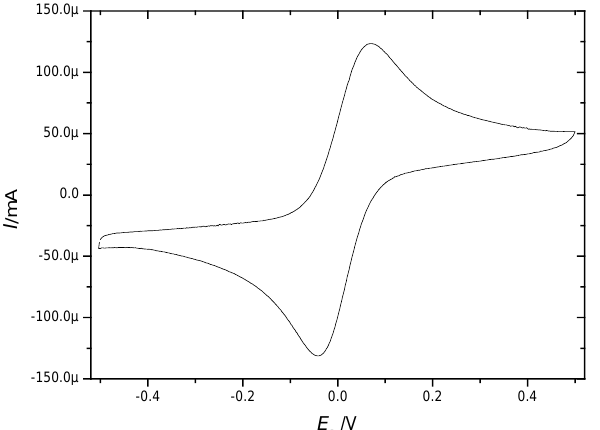
Figure 2. CV of the platinum disc electrode in contact with an aqueous electrolyte solution of 0.01 M (NH 4 ) 2 Fe(SO 4 ) 2 + 0.01 M (NH 4 )Fe (SO 4 ) 2 + 1 M HClO 4 , d E /d t = 0.1 V · s − 1 , solution de-oxygenated with nitrogen. plane) and Bode plots in Figure